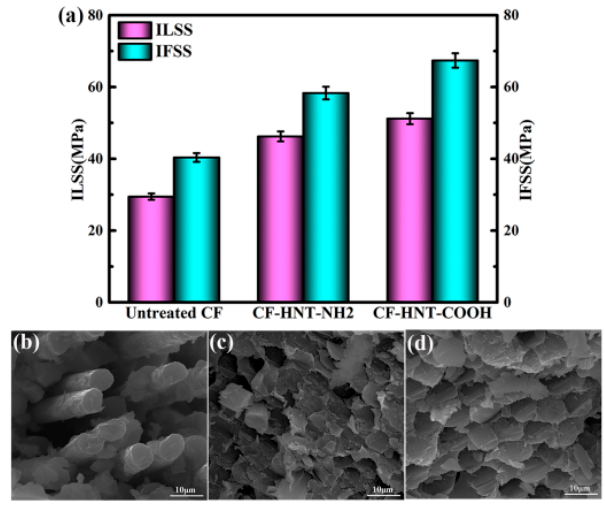
Figure 5. ( a ) ILSS and IFSS results of composites; and SEM morphologies of the fracture surface of MPSR composites reinforced with: ( b ) untreated CF; ( c ) CF–HNT–NH 2 ; and ( d ) CF–HNT–COOH.